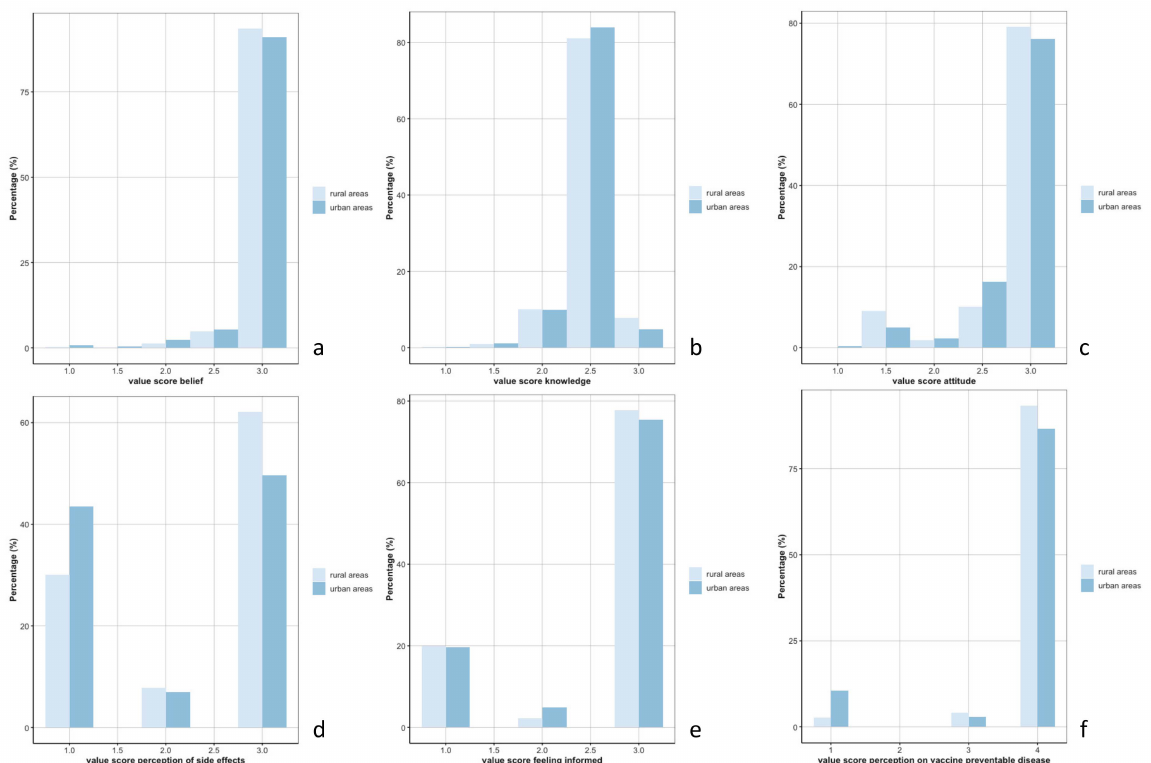
Figure 1. Distribution of the scores for the 6 concepts—( a ): belief, ( b ): knowledge, ( c ): attitude, ( d ): risk perception of side effects, ( e ): feeling informed, ( f ): risk perception on vaccine preventable diseases—between rural and urban areas.